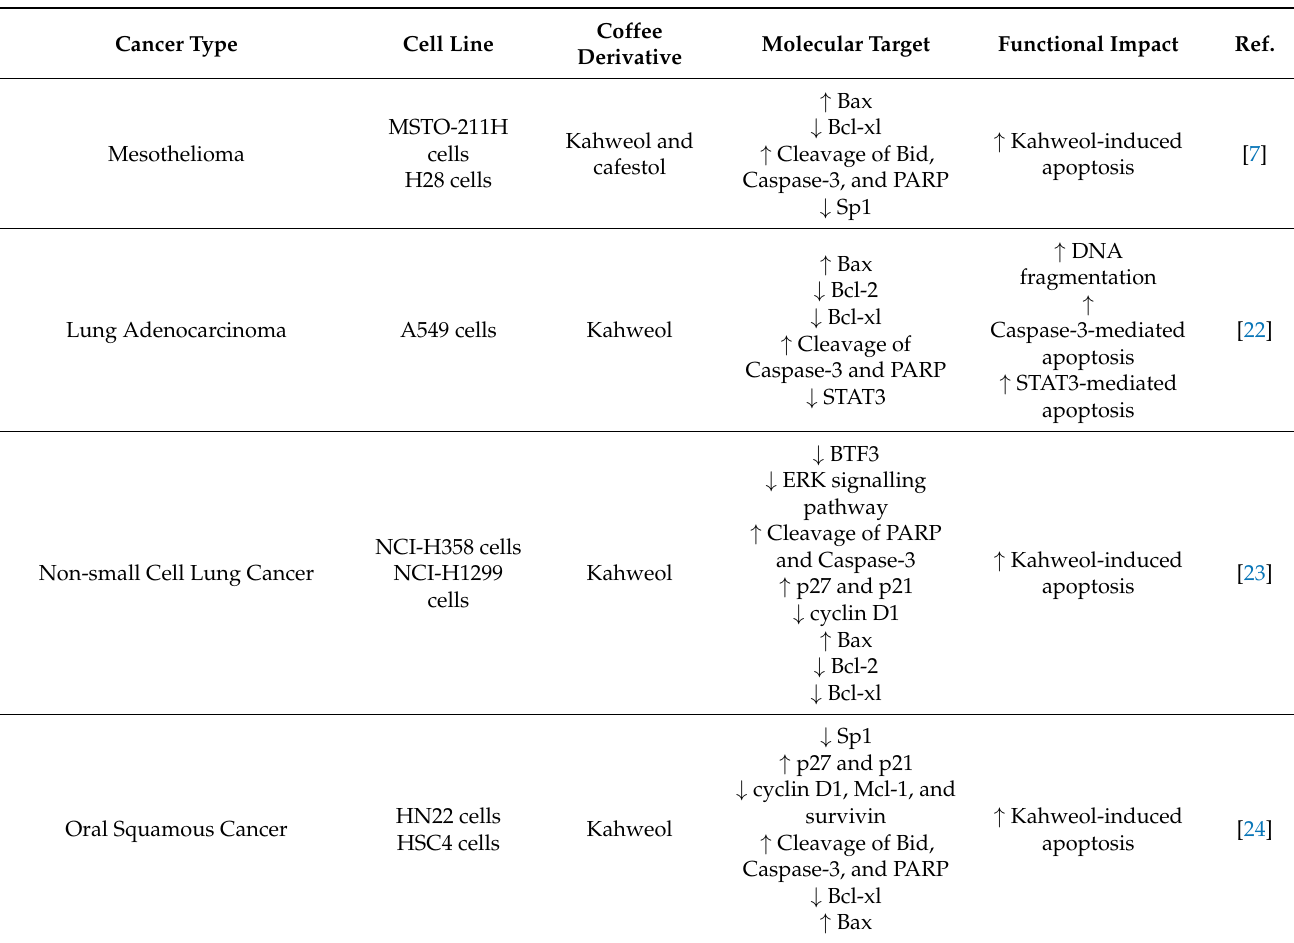
Table 1. In Vitro Impact of Kahweol and Cafestol on Cancer Cell Lines ( ↑ indicates induction, ↓ indicates